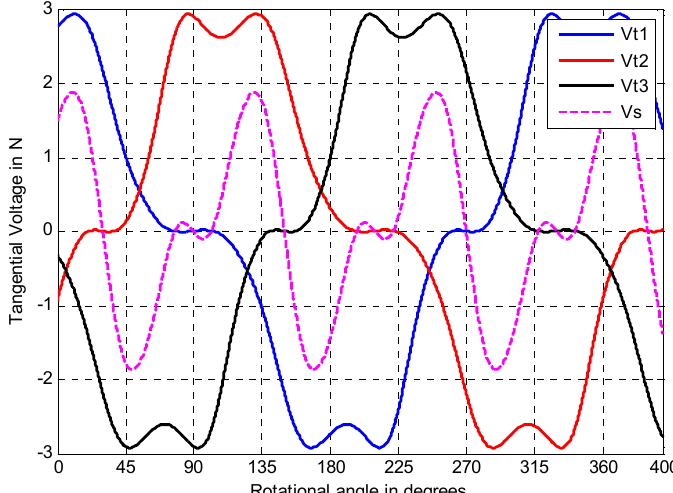
Figure 17. Tangential voltage variations of the blades as a function of the rotational angle.